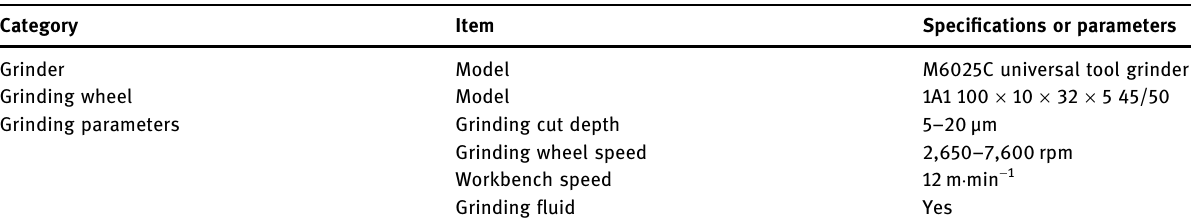
Table 3: Experiment conditions and schemes Category